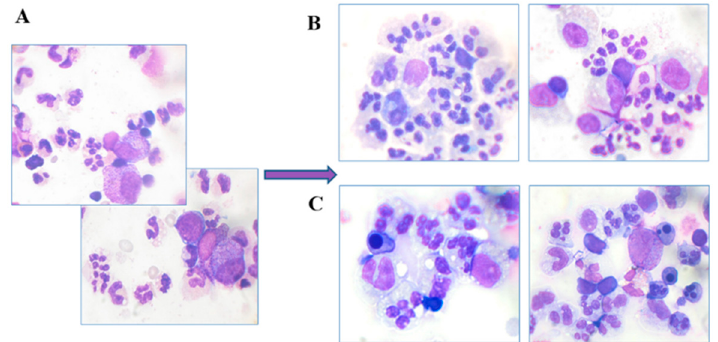
Figure 7. Human BMCs treated with ryGM-CSF-ApoA-I ( B ) and ryGM-CSF ( C ) compared to a control ( A ) for 24 h of incubation. ( A ) Blast cells, a small number of segmented neutrophils, stable neutrophils; ( B , C ) many segmented neutrophils.